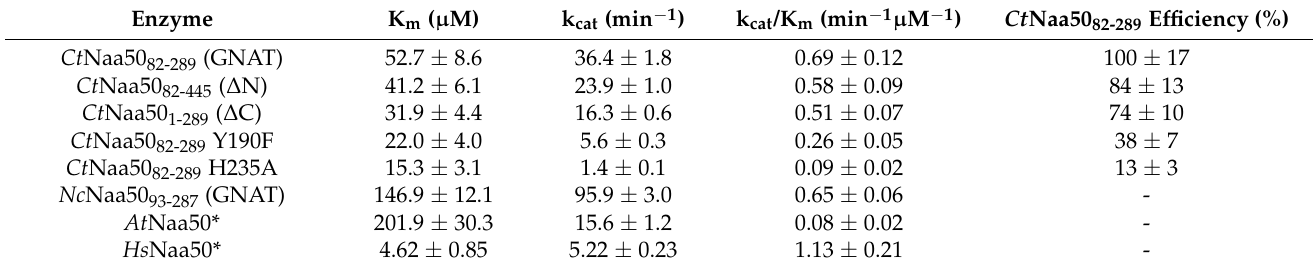
Table 1. Catalytic parameters of Naa50 acetylation activity. Acetylation was performed at 30 ◦ C, 25 ◦ C (plant), or 37 ◦ C (human) with MVNALE, MASS (plant), or MLGPE (human) peptides, respectively. GNAT indicates GNAT domain constructs, ∆ N indicates the N-terminal deletion construct, and ∆ C indicates the C-terminal deletion construct. * Values for human ( Hs ) and Arabidopsis thaliana ( At ) Naa50 were taken from [39,61]. Measurements were performed in triplicates and are presented as means ±